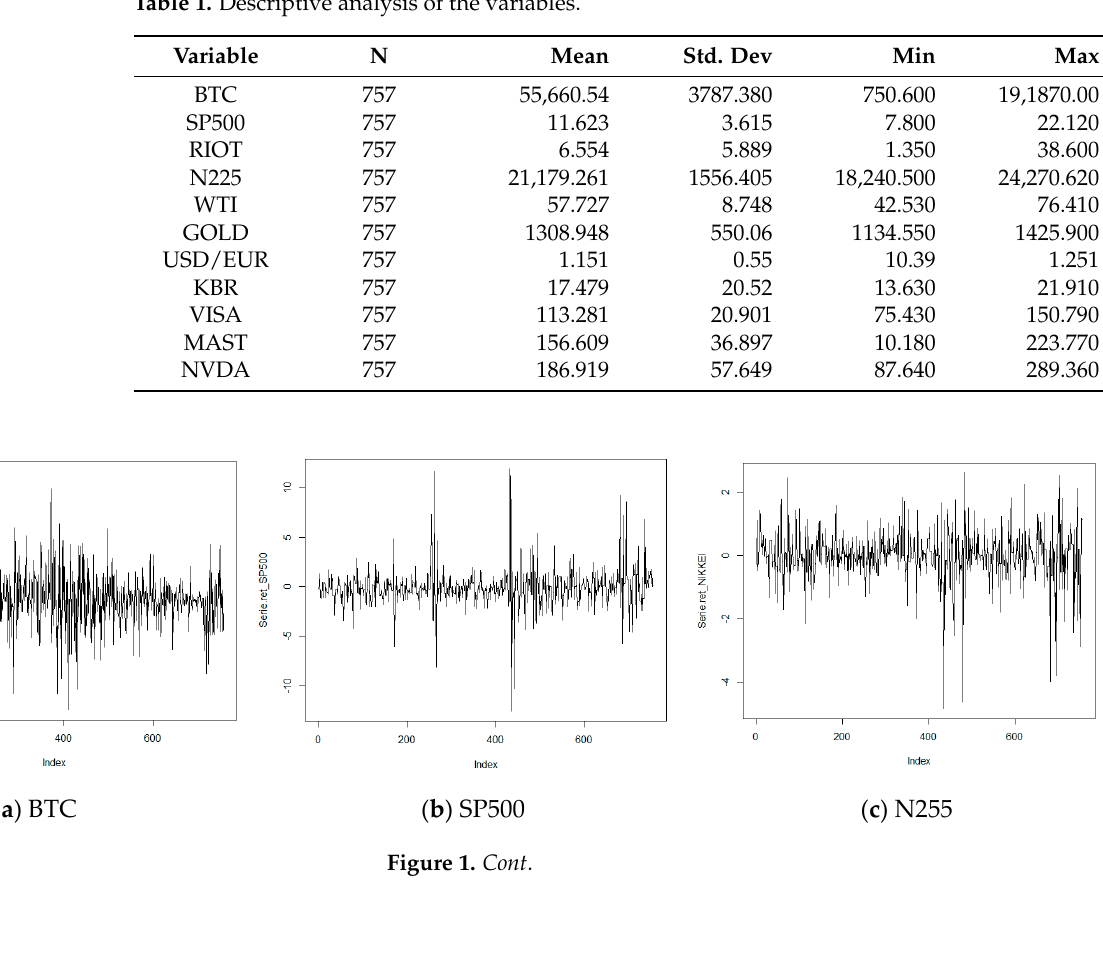
Table 1. Descriptive analysis of the variables.